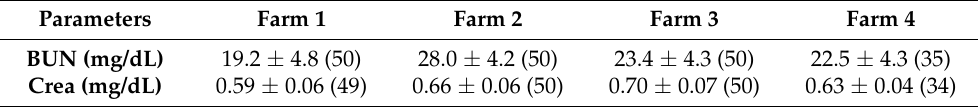
Figure 3. Values of e-GST, immune response, and infection biomarkers. Histograms show the average for the eight parameters measured for each farm (Farm 1–4). The error bars represent the standard deviations. At the top of the columns, the asterisks represent the p -values (see Materials and Methods) ( p ≤ 0.05 (*), p ≤ 0.01 (**), and p ≤ 0.0001 (****)). Table 3. Values of biomarkers of kidney efficiency measured for the examined farms.